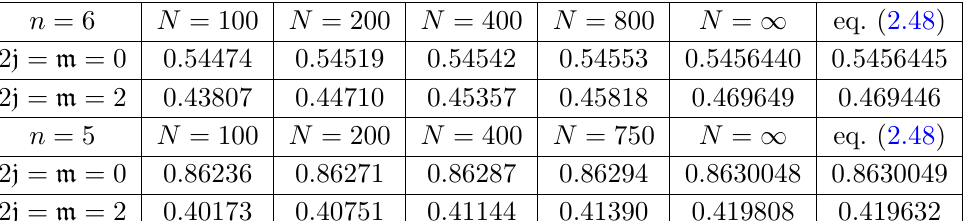
Table 6 . The regularized value t ( N; reg) to the expression for t 1